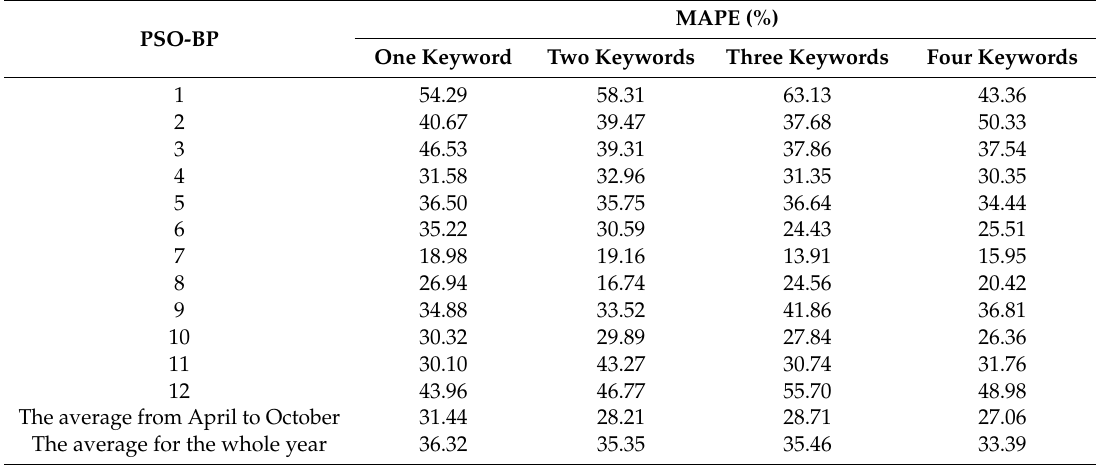
Table 6. Results of PSO-BP model including the web search data with 1–4 keywords as input.